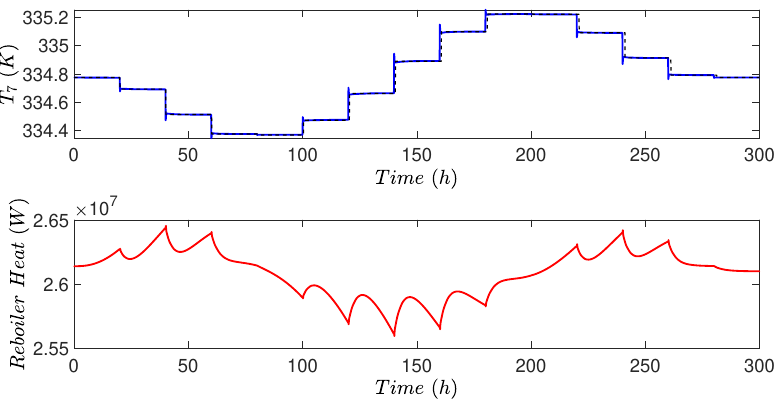
Figure 15. Controlled output T 7 and manipulated input reboiler heat for the temperature controller TC in the distillation process under the proposed RTO